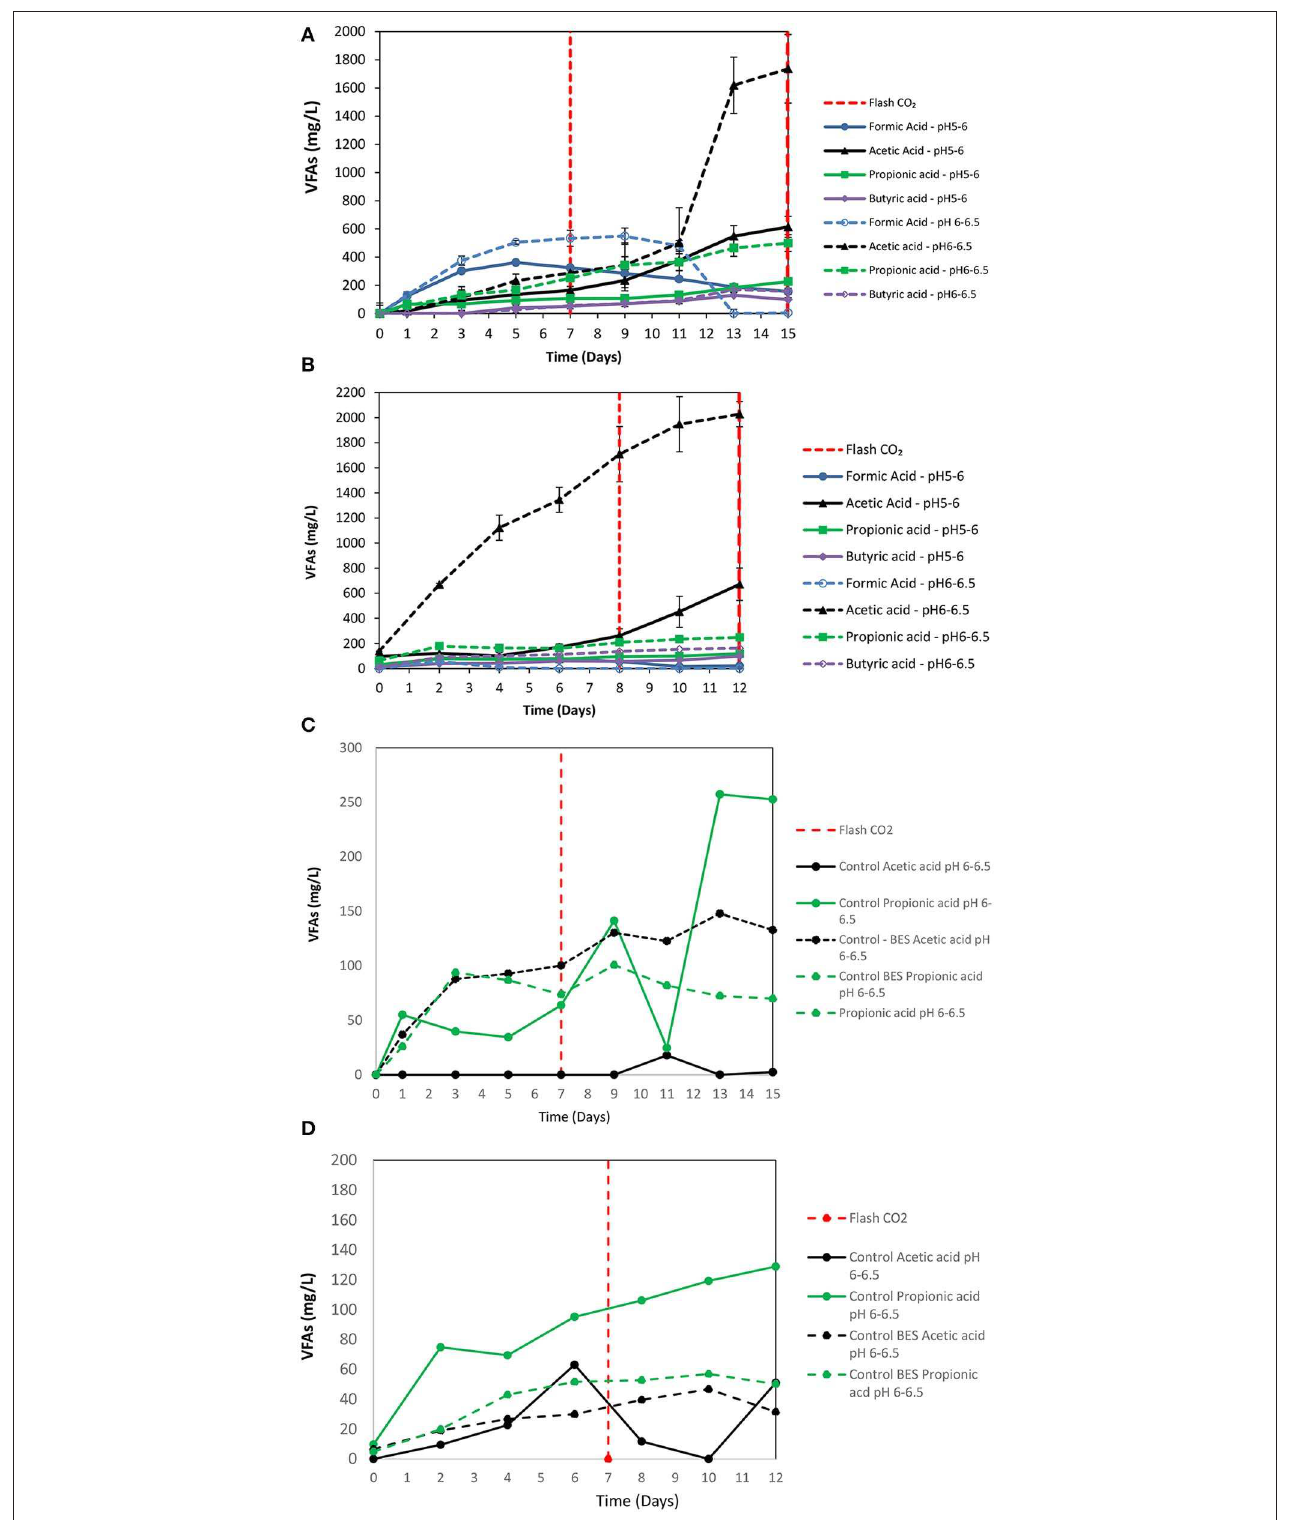
FIGURE 6 | (A) First batch: VFAs production over time for anaerobic granular sludge with 50mM BES, 100 g/L ZVI and operation at pH 5–6 and pH 6–6.5, respectively. (B) second batch: VFAs production over time for anaerobic granular sludge with 50mM BES, 100 g/L ZVI and operation at pH 5–6 and pH 6–6.5, respectively. (C) VFAs production over time for anaerobic granular sludge (control) and anaerobic granular sludge with BES and operation at pH 6–6.5. No ZVI were added in the controls. (D) VFAs production over time for anaerobic granular sludge (control) and anaerobic granular sludge with BES and operation at pH 6–6.5. No ZVI were added in the